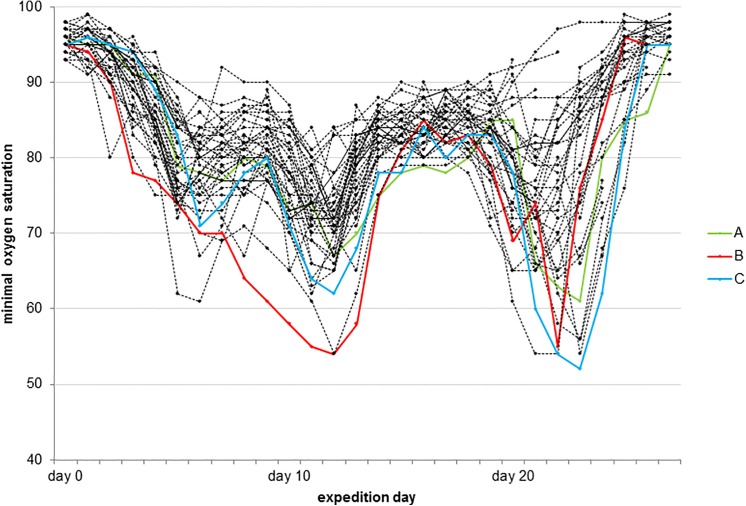
Oxygen saturation of all climbers during the expedition.Oxygen saturation measured by pulse oximetry of all climbers during the expedition. Oxygen saturation measurements of subjects with new findings in post-expedition MRI are indicated in color.